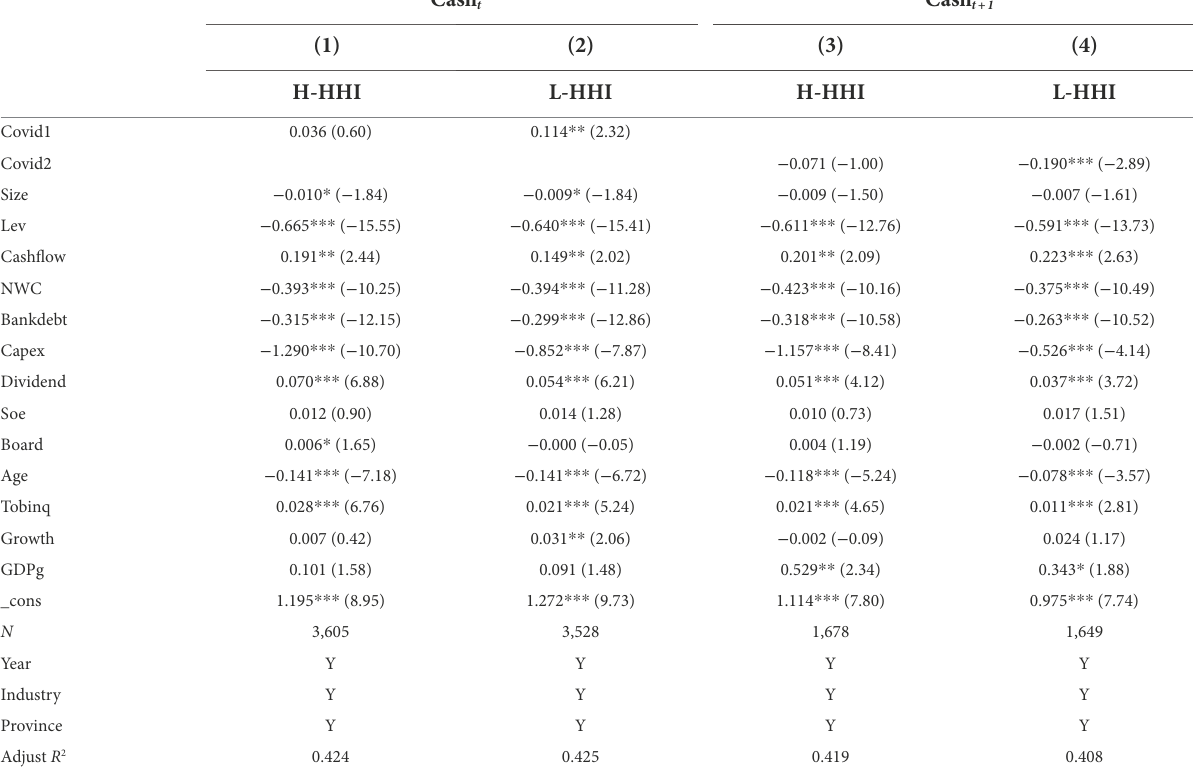
TABLE 14 COVID-19 impact and corporate cash holdings: based on industry